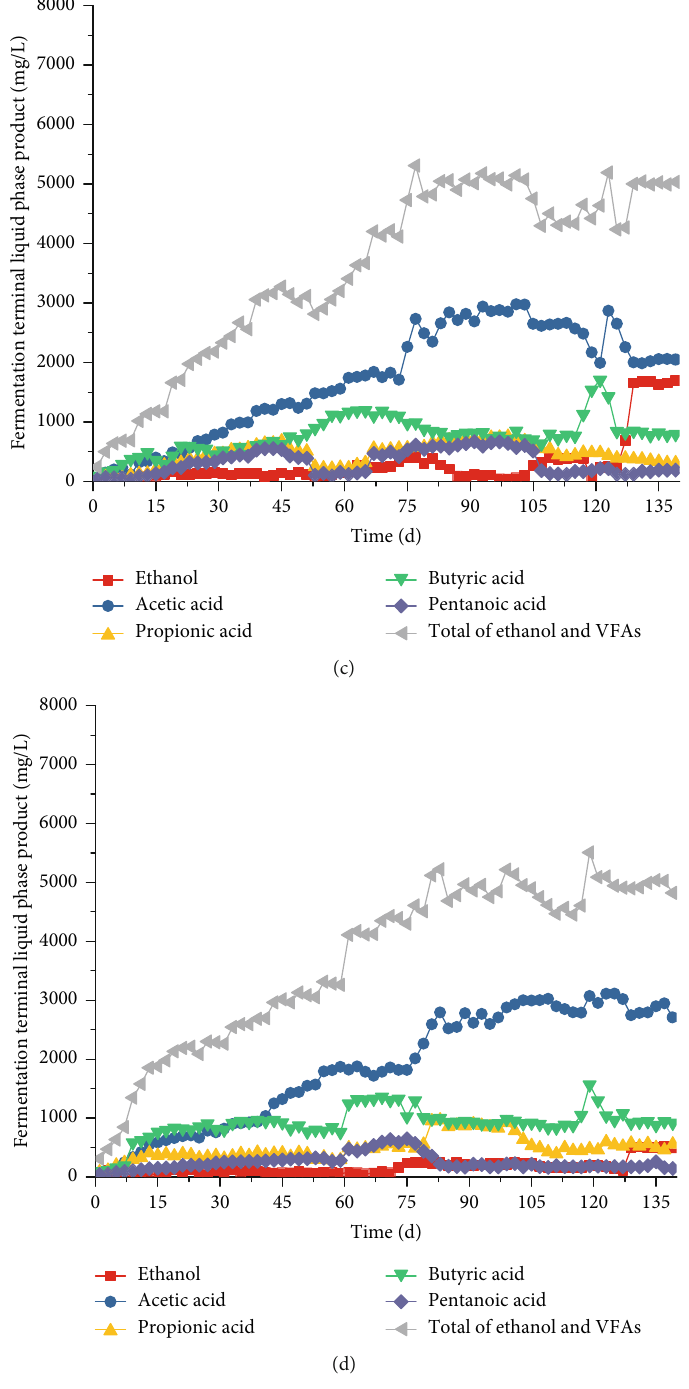
Figure 8: Variations in ethanol and VFAs ((a) compartment 1, (b) compartment 2, (c) compartment 3, and (d) compartment